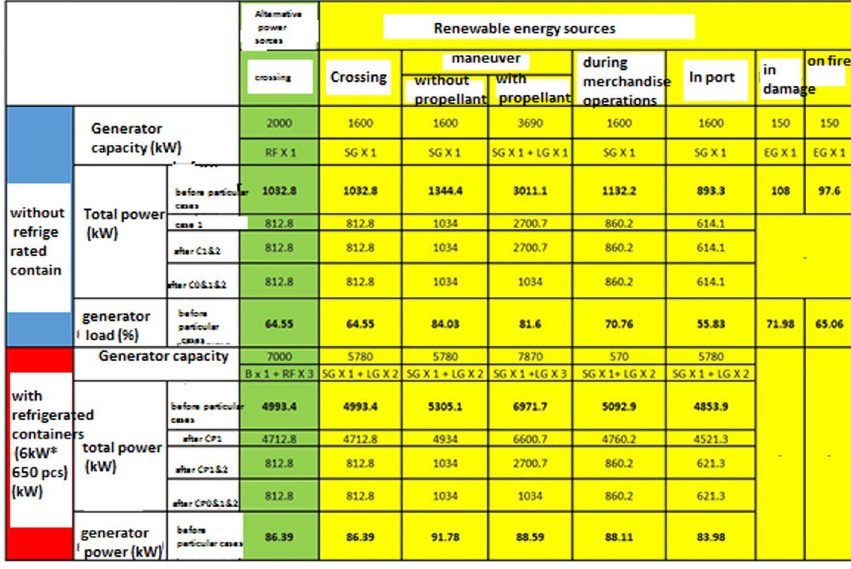
Fig. 3 Operational container ship data (Vasilescu and Dinu